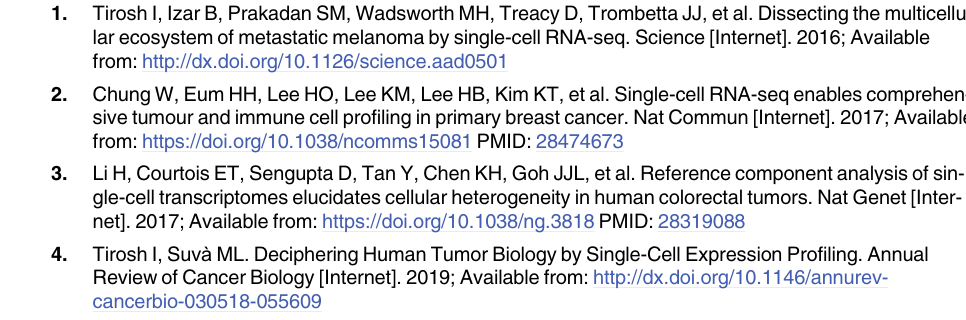
S2 Fig. Example searchable parameters to filter scRNA-seq datasets. A set of searchable parameters can be used to filter scRNA-seq datasets. The users can search for specific datasets using user-specified parameters, and return one specific dataset as a SingleCellExperiment object for downstream analysis. S1 Table. Metadata of TMExplorer. The metadata table contains information such as GEO accession, author, journal, year, PMID, sequencing technology, expression score type(s), source organism, type of cancer, number of patients, tumours, cells and genes, and the data- base that the data was obtained